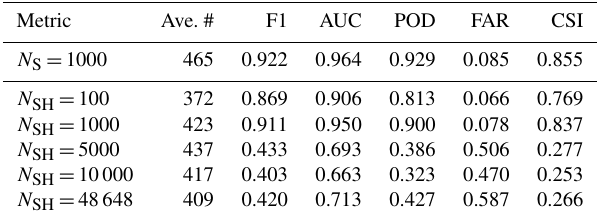
Table 3. The same mask prediction performance metrics shown in Table 2 are listed for predicted particles paired to true particles av- eraged over the 10 test synthetic holograms. The match distance threshold used was